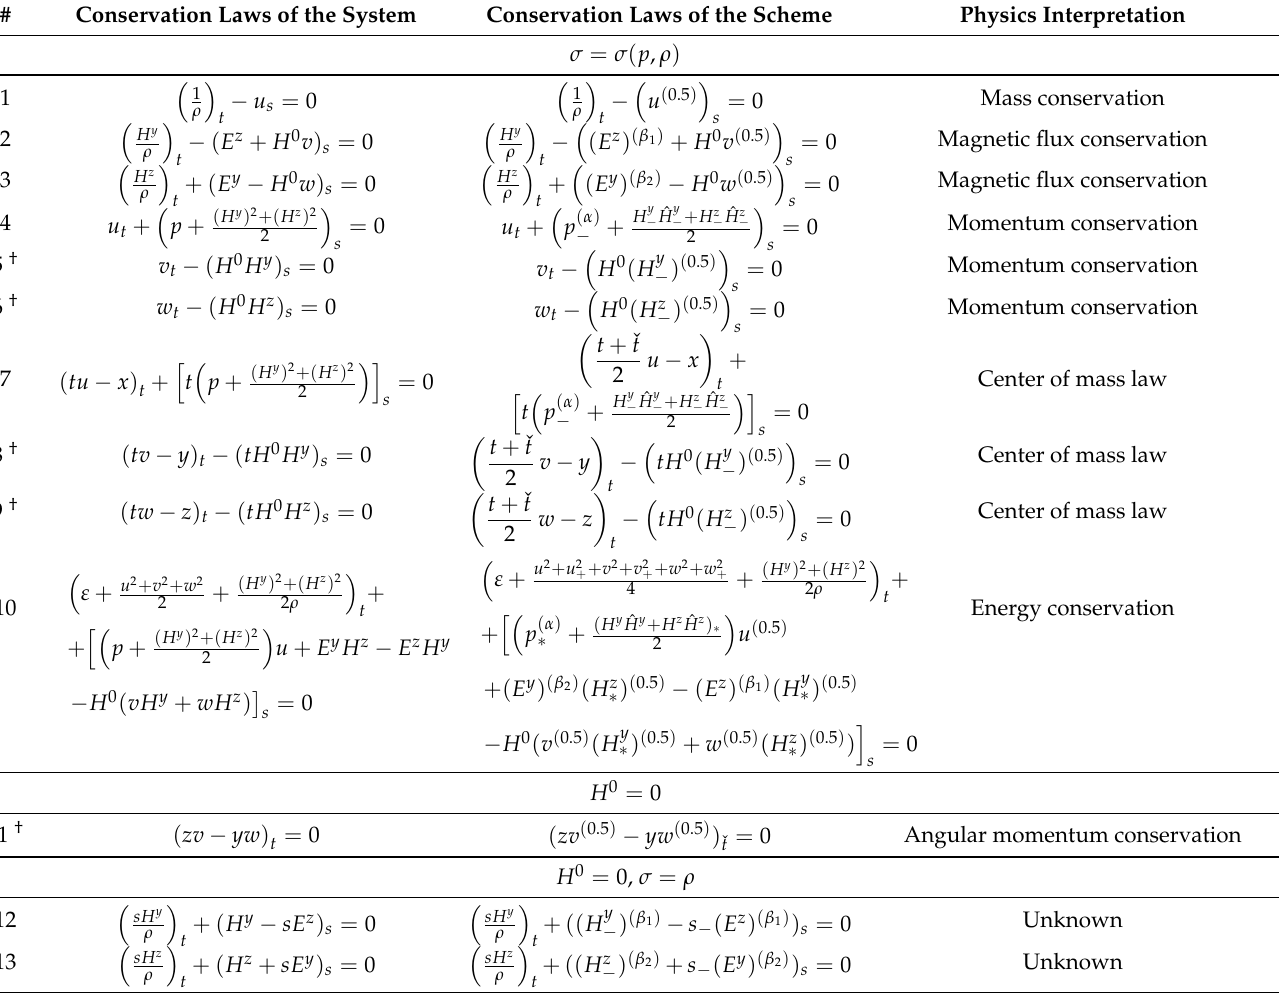
Table 2. Differential and difference conservation laws for the extended